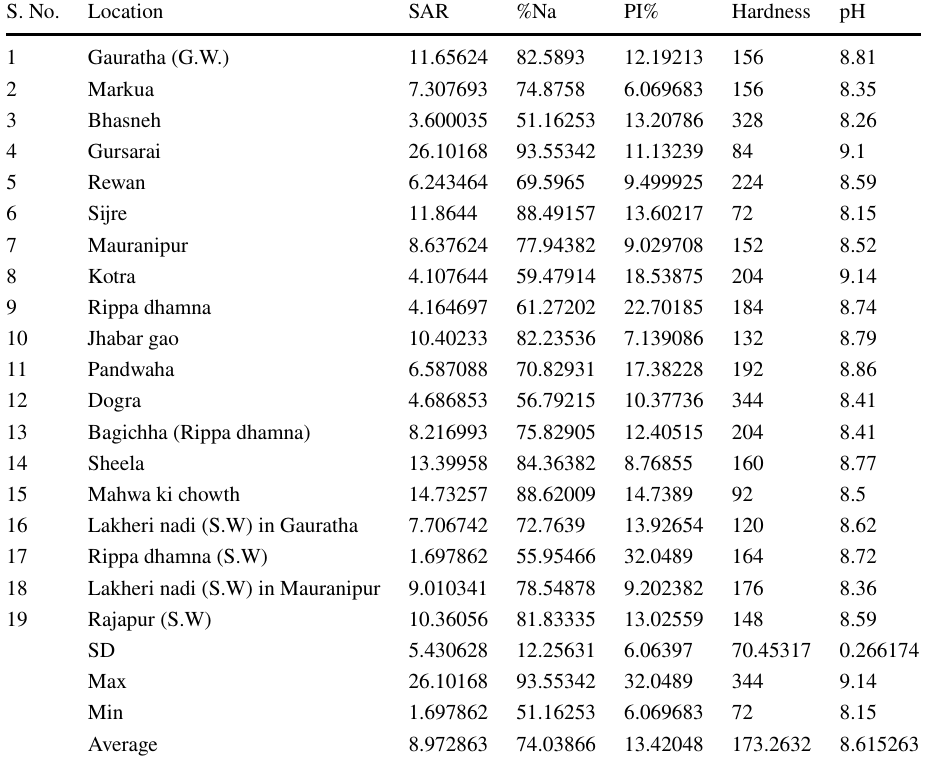
Table 2 Hydro-chemical